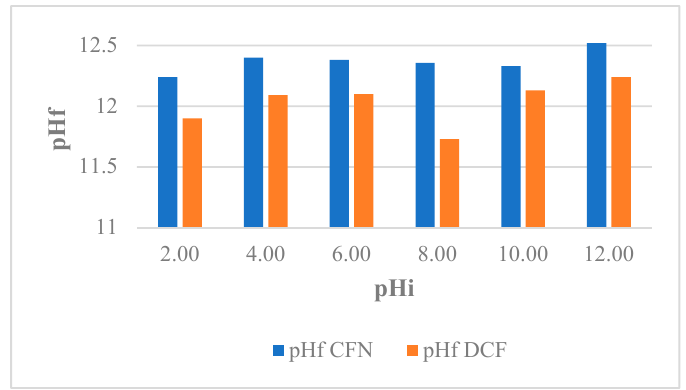
Figure 3. Variation pH of caffeine (CFN) and diclofenac (DCF) solutions evaluated for FB850-3.